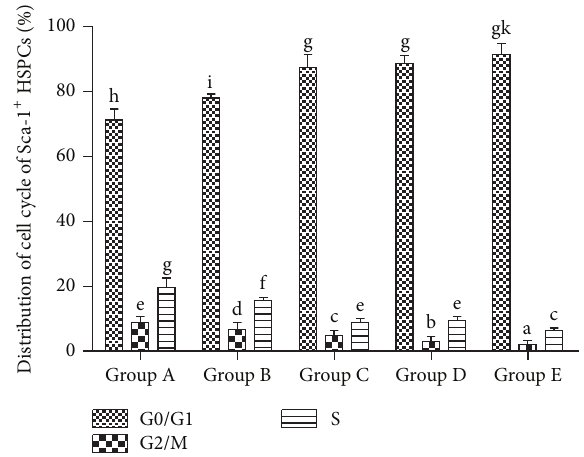
Figure 4: Distribution of cell cycle of Sca-1 + HSPCs (%, 𝑥 ± 𝑠 , 𝑛 = 10 ).GroupA:3-4-week-oldmice,13–16 ginbodyweight.Group B: 8-9-week-old mice, 20–25 g in body weight. Group C: 6-month- old mice, 35–40 g in body weight. Group D: 12-month-old mice, 39– 43 g in body weight. Group E: 18-month-old mice, 37–45 g in body weight. (a–k) represent a significant difference of these columns ( 𝑃 < 0.05 ).